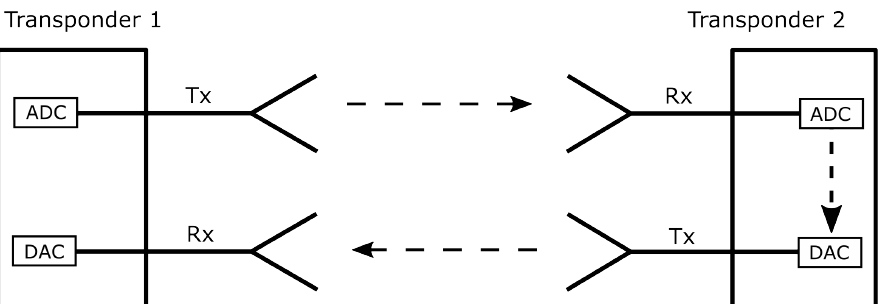
Figure 1. Measurement scheme for a transponder in radar (on the left) and in transponder mode (on the right). In transponder mode, the transmitter and the reception chain are connected in the digital